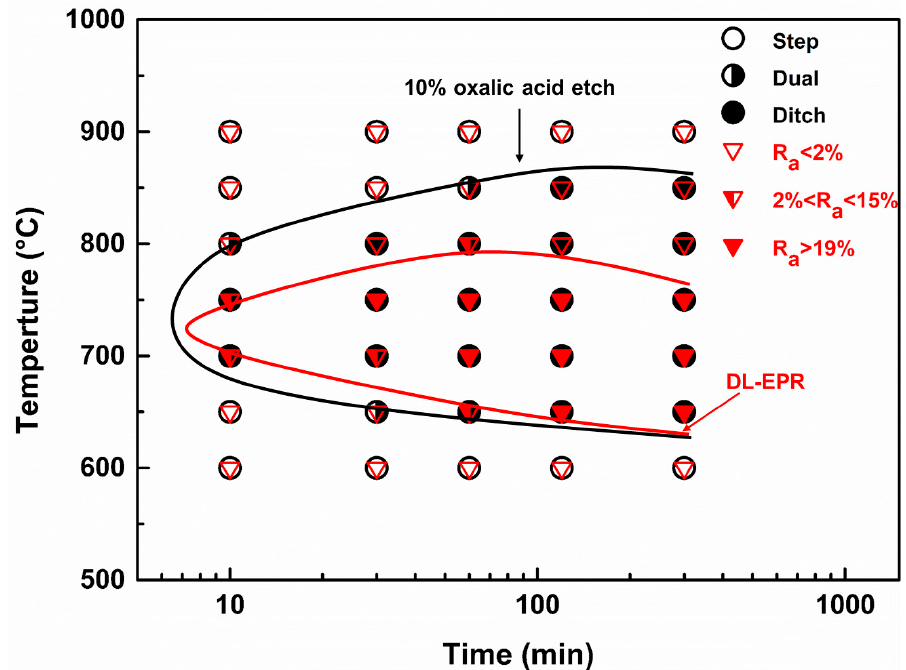
Figure 10. Time-temperature-sensitization (TTS) curves of the Cr–Mn–Ni–N–Cu austenitic stainless steel based on the 10% oxalic acid etch and the DL-EPR test. The red inverted triangles and black circles represent the results of DL-EPR test and oxalic acid etch, respectively.